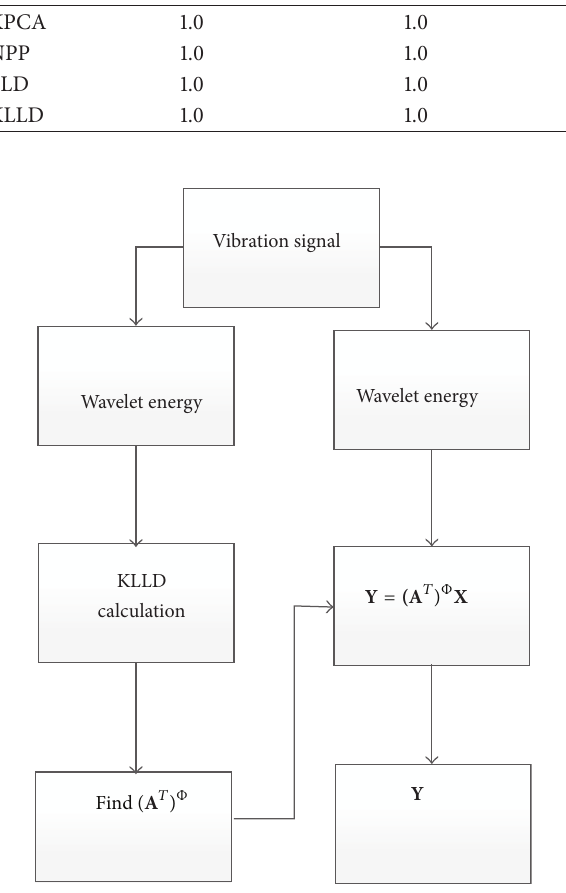
Figure 3: Scheme of KLLD dimension reduction for rolling bear